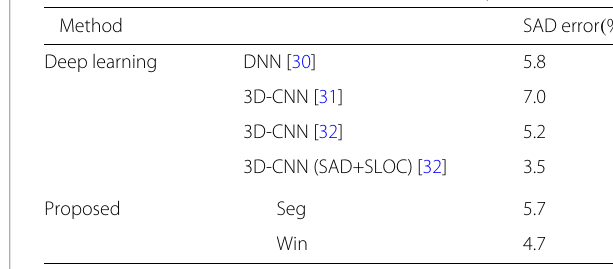
Table 8 Performance (in overall SAD detection error [77]) of deep learning-based approaches vs. the proposed algorithm for room-localized SAD on the DIRHA-sim-evalita